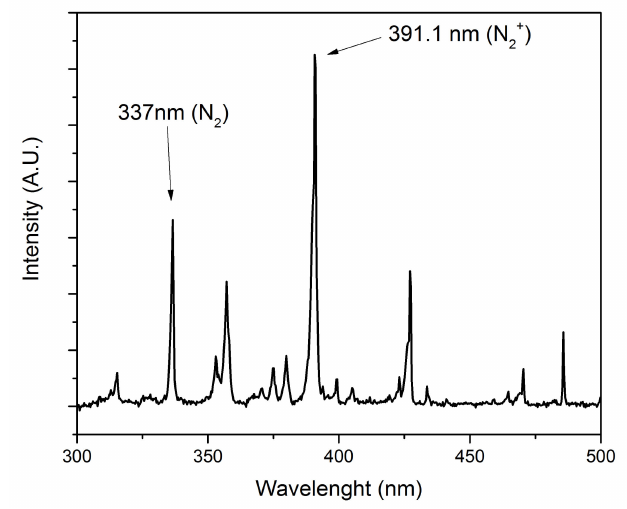
Figure 2. Emission spectrum for nitrogen